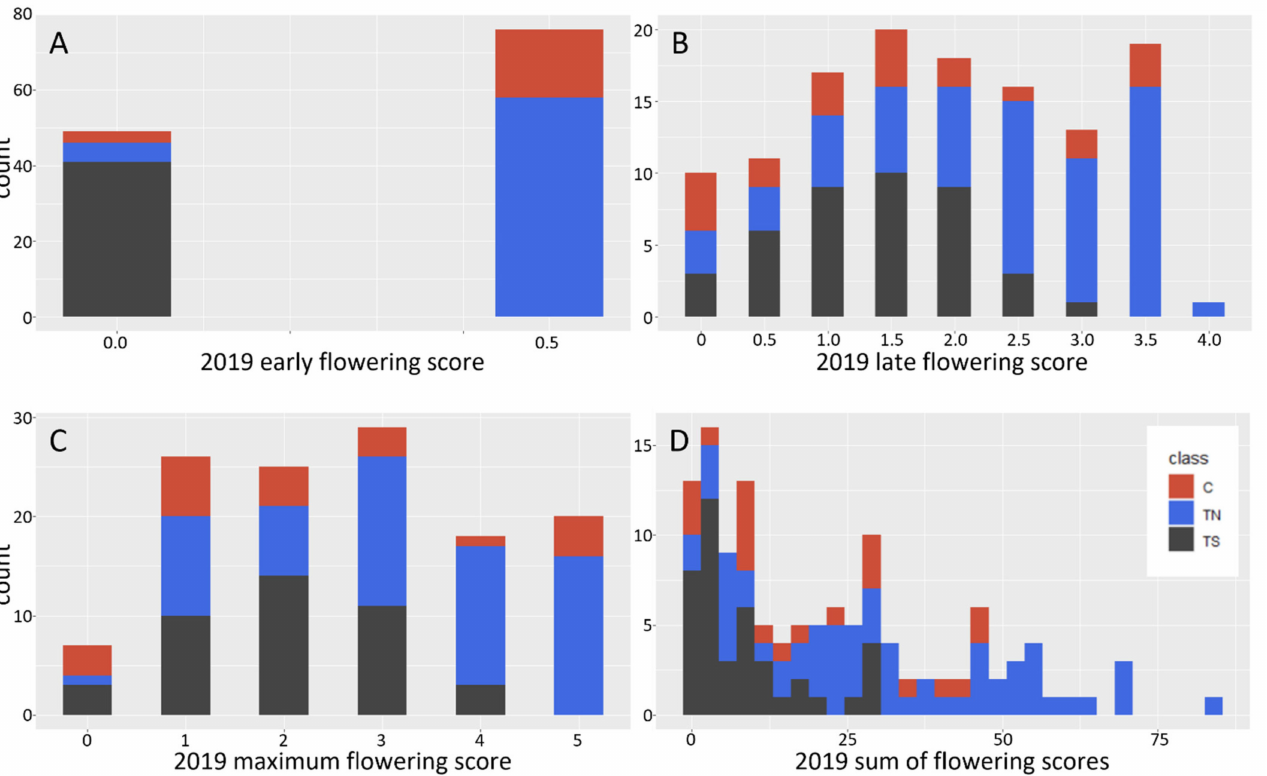
Figure 2. Floral timing and abundance varied among genotype classes, in all panels C is non-transgenic control (shown in red), TN is transgenic normal (shown in blue), TS is transgenic sterile (shown in dark grey). A numeric scoring system was used to score the timing of floral opening for all trees, with 0 no open buds, and a 0.5 to 5.0 relative scale for the number of open buds. ( A ) The first two weeks of the 2019 floral bud flush were designated “early flowering.” Trees with scores of 0 had no open flower buds, trees with scores of 0.5 had 10 or fewer open catkins. ( B ) Weeks 3–7 of the 2019 floral bud flush were designated “late flowering.” Here, a relative scale from 0–4 was used to score the number of open catkins (details in methods). ( C ) The maximal flowering score (number of open catkins) was determined for all trees. The distribution of this score was similar for C and TN groups, but still reduced for TS trees. ( D ) The metric “sum of flowering scores” is the actual counted number of open flowers per tree, TS trees tended to have the lowest scores, likely due to their delayed floral bud flush as seen in ( A ).